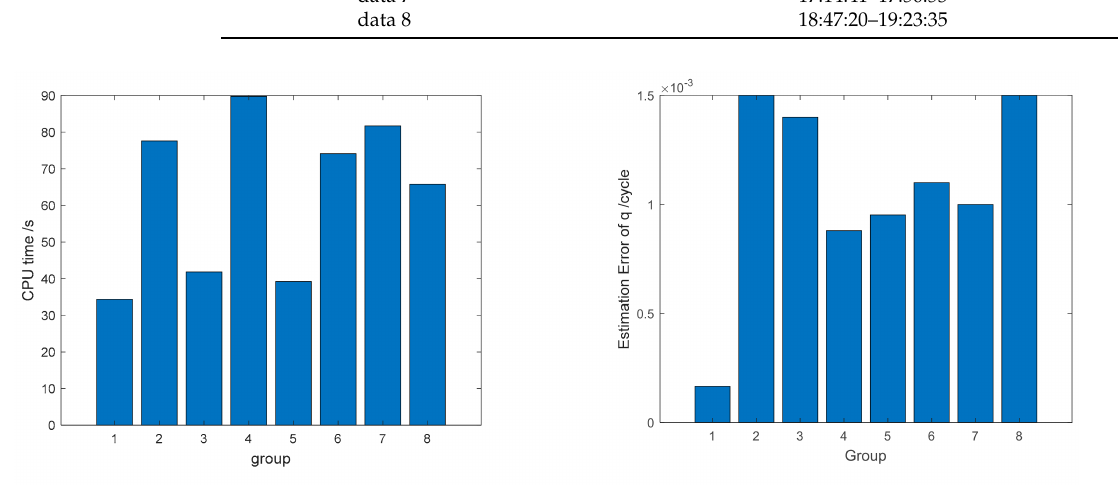
Figure 10. Crab pulsar real data results.